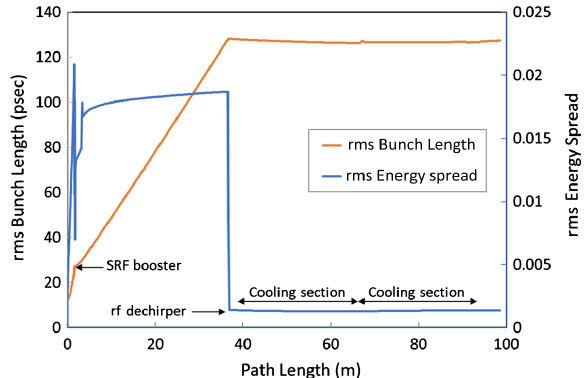
FIG. 3. Simulated rms bunch length and rms energy spread along the beam line from the gun to the beam dump for a bunch charge of 75 pC and a kinetic energy of 1.6